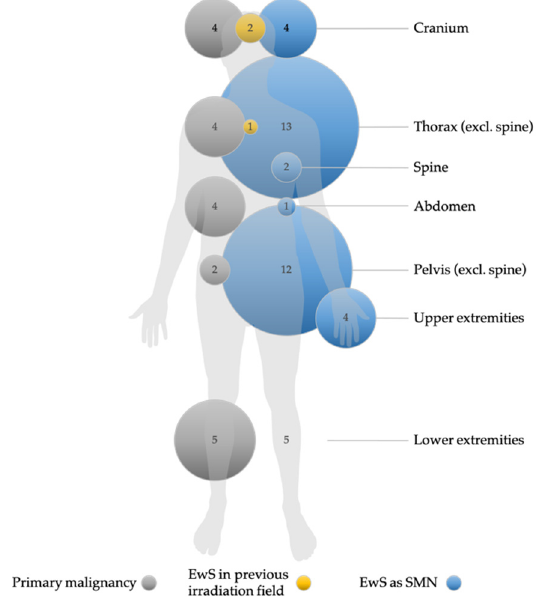
Figure 1. Localization and frequency of primary malignancies and Ewing sarcoma as secondary malignant neoplams (EwS as SMN), and occurrence of EwS as SMN in previously irradiated fields. Non-EwS malignancies are shown with gray circles, EwS cases with blue circles, and cases of EwS as SMN in previously irradiated fields with yellow circles. The numbers indicate the number of tumors per localization. The size of the circles is proportional to the number of cases. Missing circles mean no tumor case in this localization. Data for primary malignancies, EwS as SMN, and EwS as SMN in previously irradiated localizations (i.e., information on treatment modalities) were available in n = 36, n = 41, and n = 27, respectively. Nine patients were irradiated in the primary tumor setting.